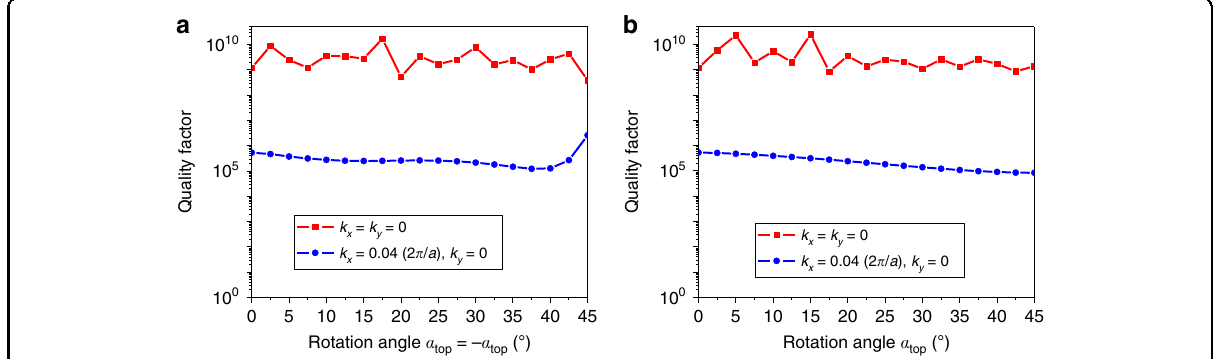
Fig. 3 Evolution of the quality factor at BIC and QBIC as the rotation angle increasing from 0° to 45°. a is the case with two layers rotates in opposite directions simultaneously. b is the case with only the top hole having rotation angle, and the bottom hole is unperturbed